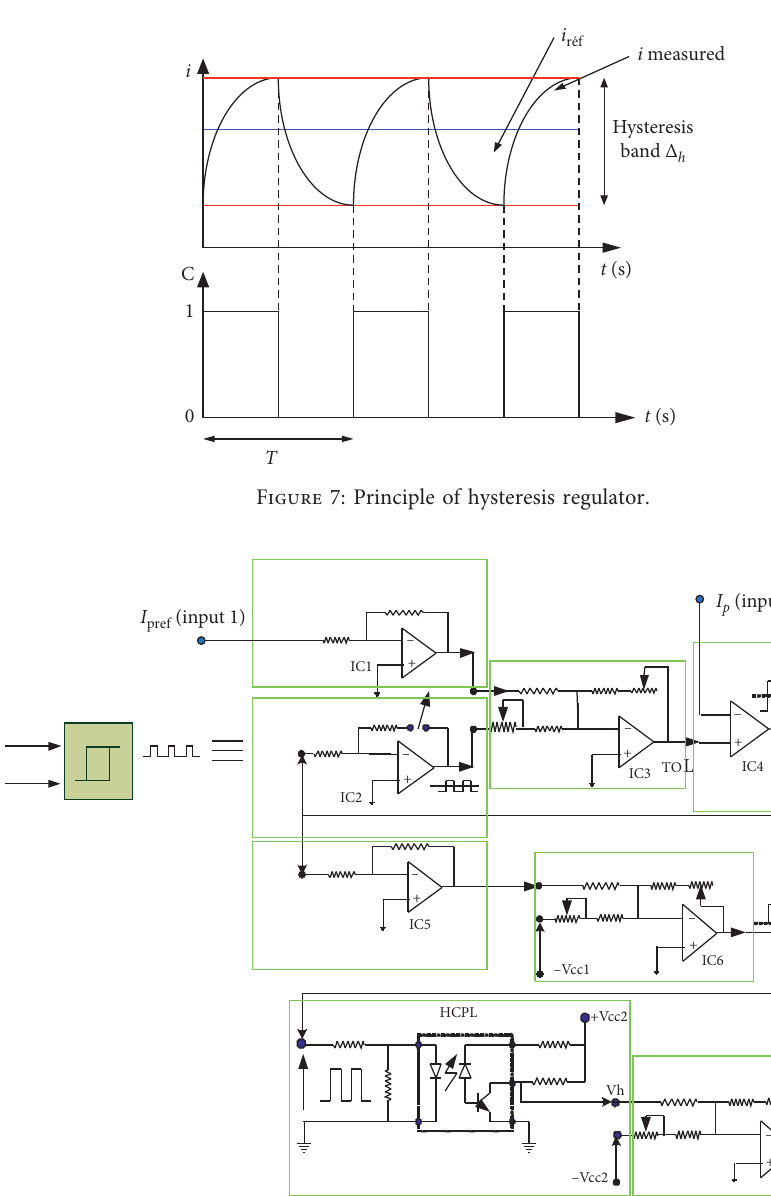
Figure 8: Design of a hysteresis current regulator.